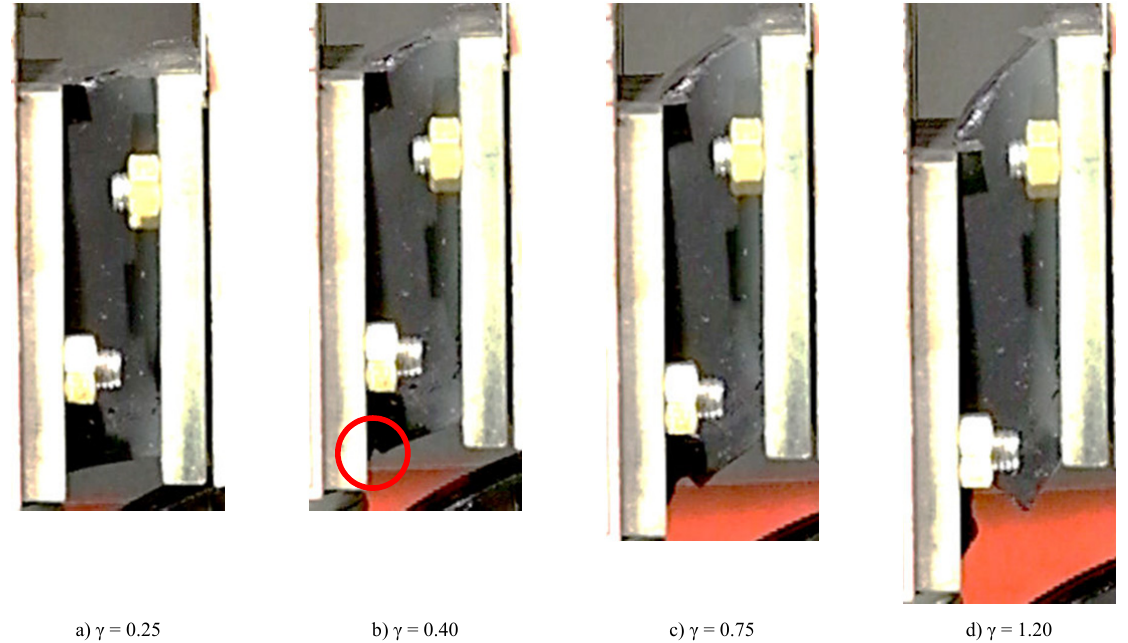
Fig. 16 Observed deformations for the points given in figure 15. γ is the engineering shear